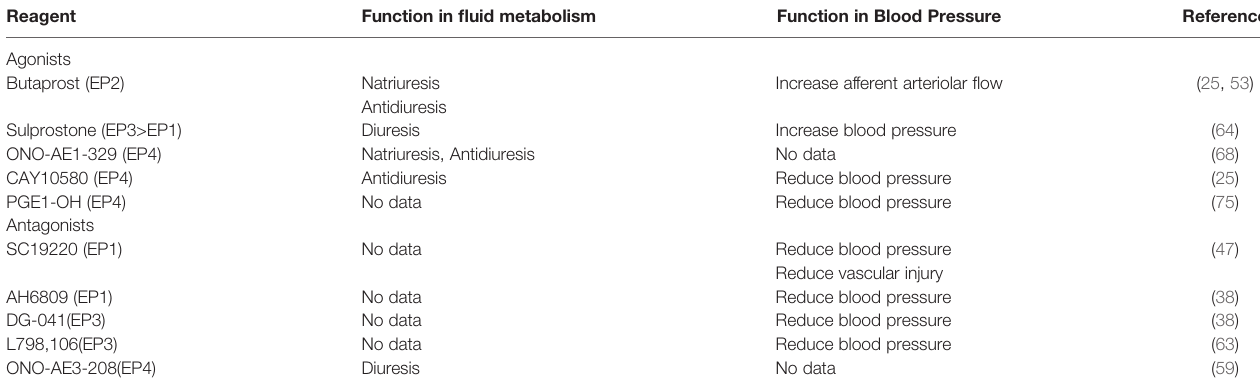
TABLE 1 | Roles of EP receptors agonists/antagonists in the regulation of fl uid balance and blood pressure.